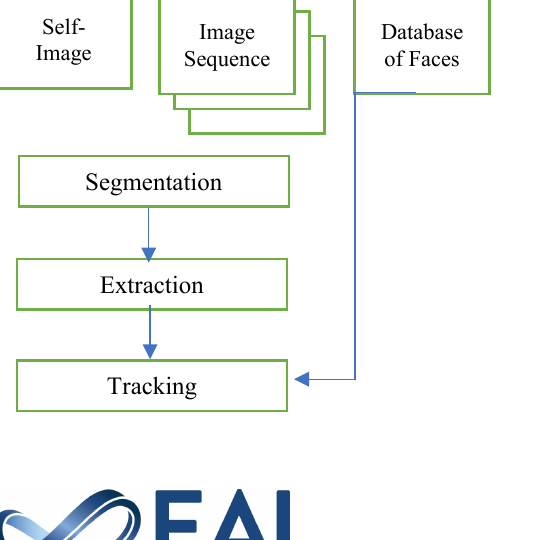
Figure 3 . Face Recognition Techniques [3]